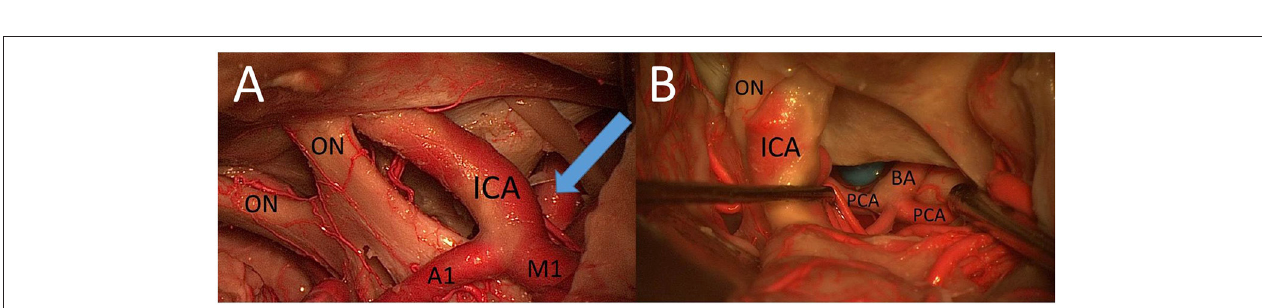
FIGURE 8 | (A) CS window from PT perspective. (B) The prepontine area through the caroticosylvian window using the PT approach: mobilization of the ICA was necessary to increase the view to the BA, the PCA, the rami ad pontem, and the anterior upper surface of the brainstem (ON, optic nerve; A1, proximal segment of anterior cerebral artery; M1, proximal segment of middle cerebral